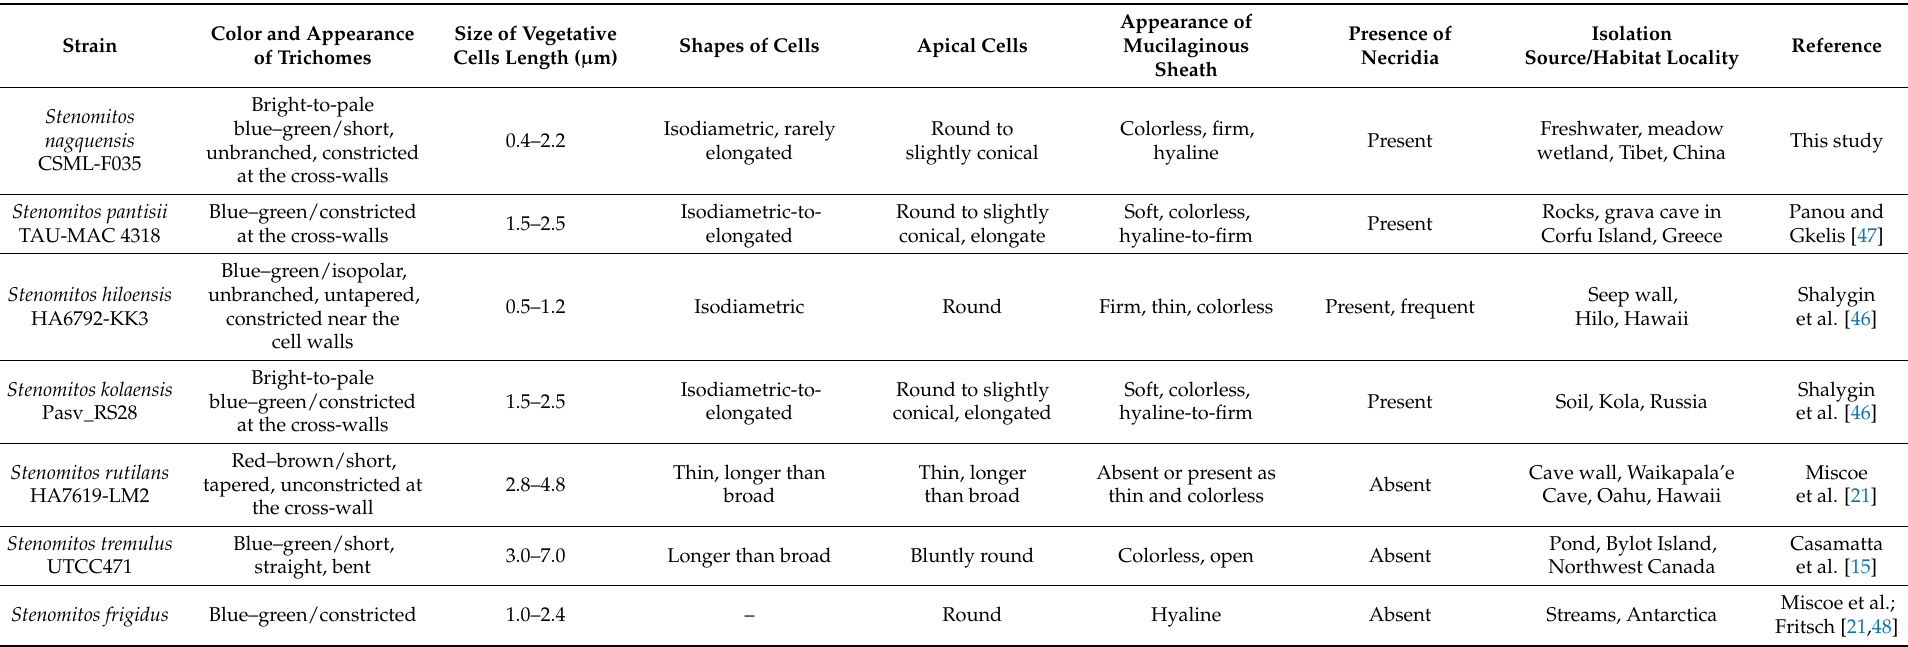
Table 3. Morphological comparisons of Stenomitos nagquensis sp. nov and known Stenomitos